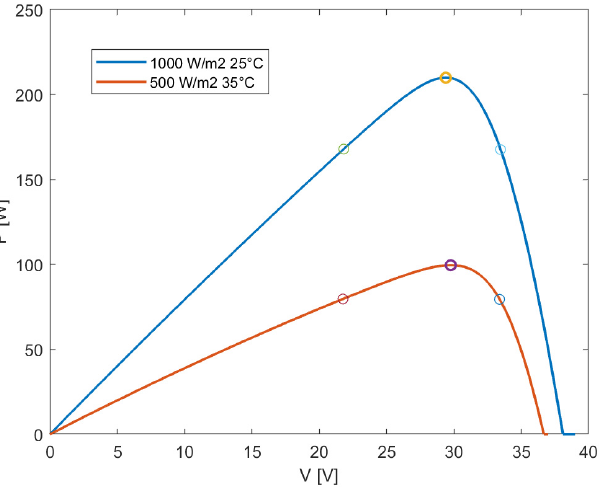
Figure 1. Power ‒ voltage curve of a PV module for two different ambient conditions, showing the maximum power point (MPP) and the possible reference operating points for a 20% reserve.